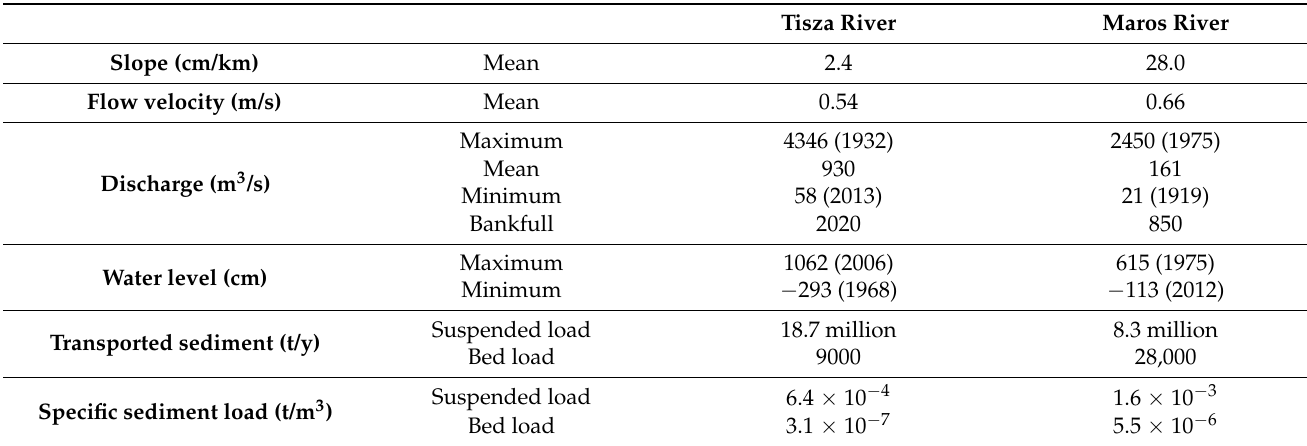
Table 1. Main hydrological parameters of the Tisza at Szeged and the Maros River at Mak ó gauging stations. At the extreme values, the year of measurement is also indicated